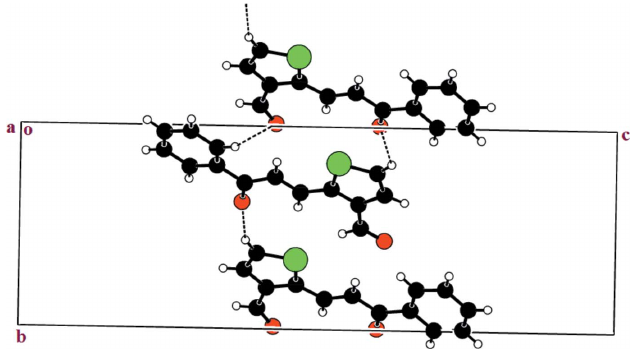
Figure 2 A view along the b axis of the partial crystal packing of the title compound. Hydrogen bonds are shown as dashed lines.